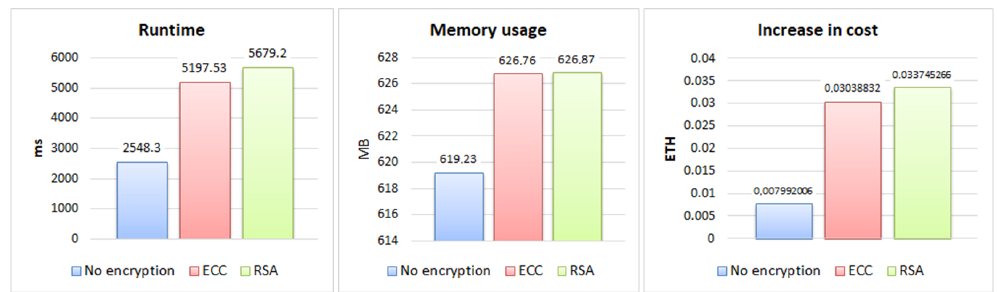
Figure 7. Results of submitting a file